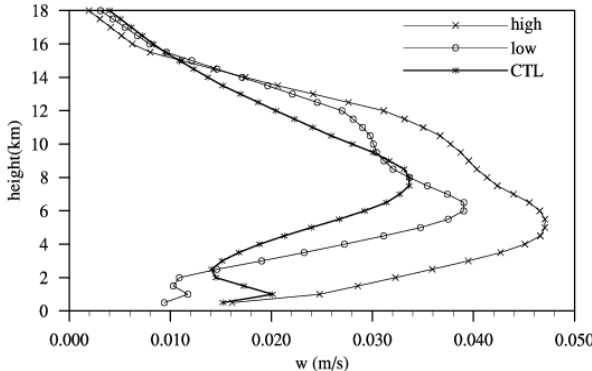
Figure 10. Domain averaged updraft in all three tests (m s − 1 ).